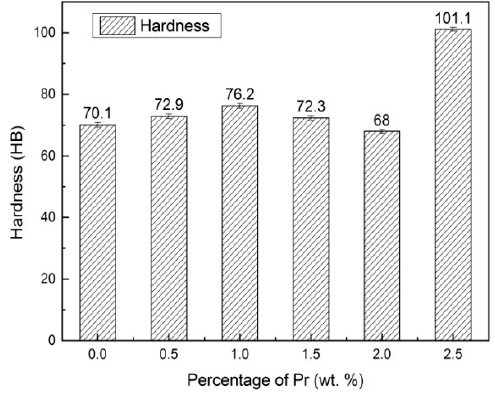
Figure 6. Effect of Pr content on the hardness of alloys.